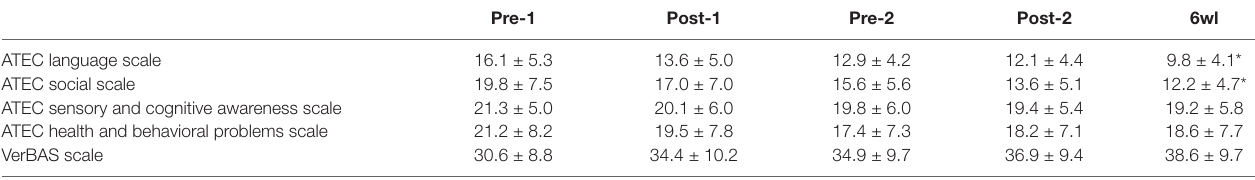
TABLE 3 | Autism Treatment Evaluation Checklist (ATEC) scale scores and Verbal Behavior Assessment Scale (VerBAS) scores at each assessment time point (mean ± SD).